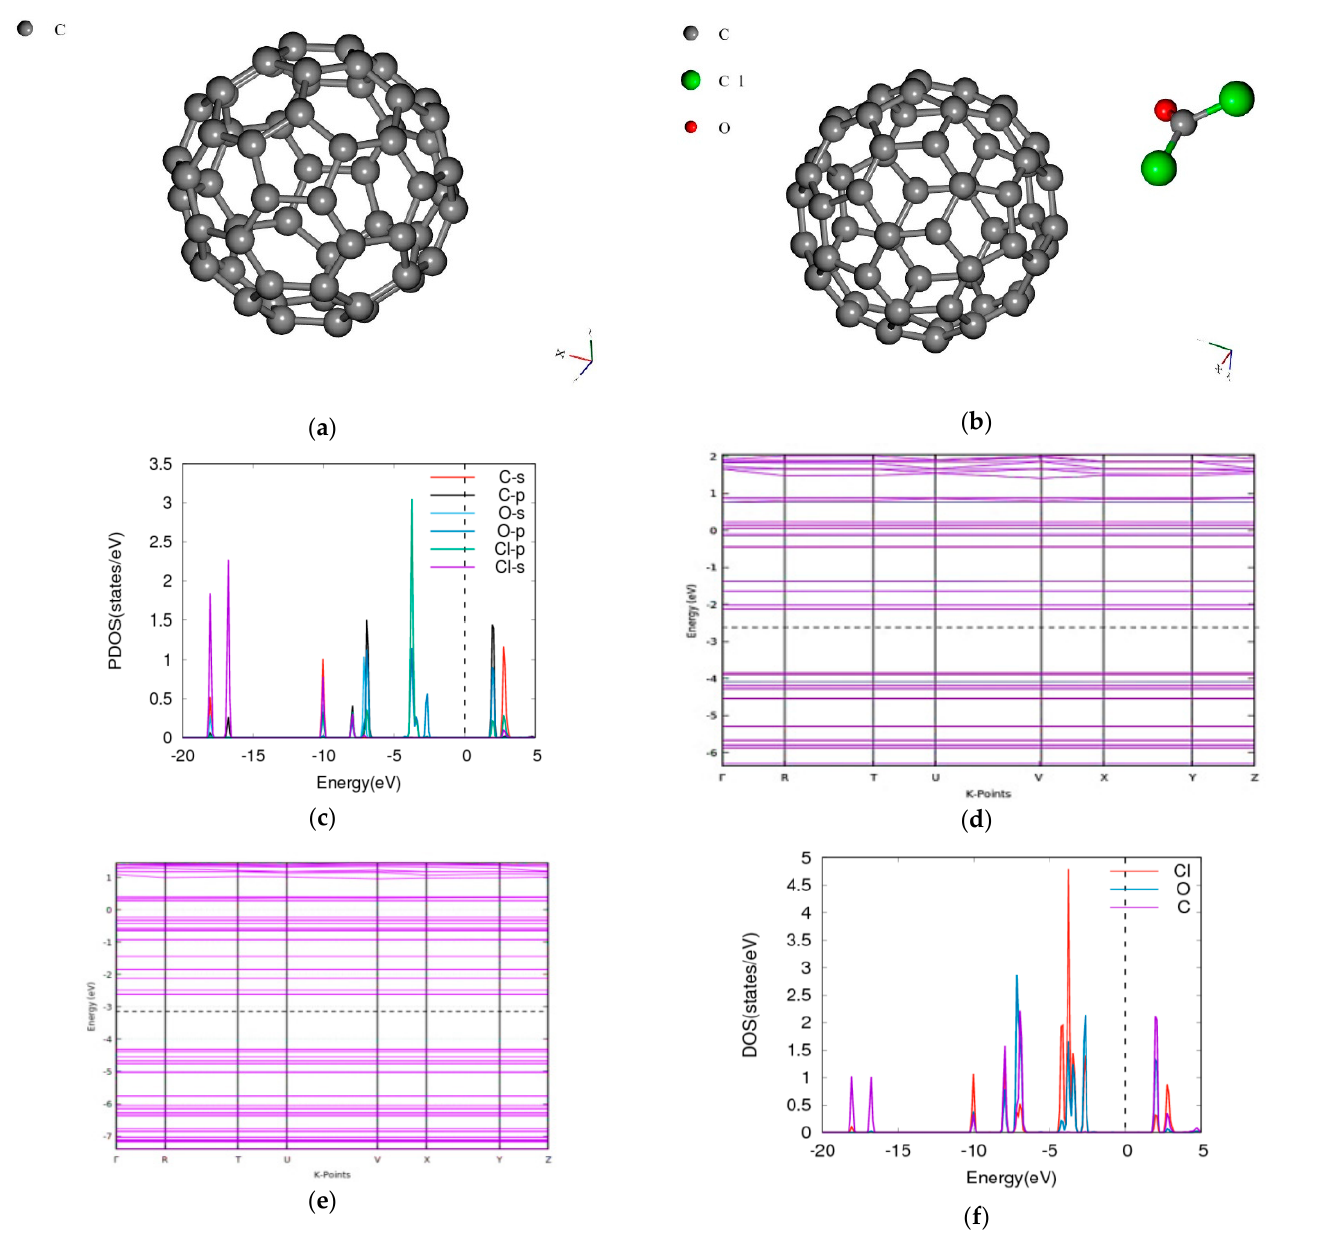
Figure 4. Band structure and density of states for phosgene gas interaction with C60. ( a ) C60, ( b ) phosgene- C60, ( c ) phosgene-C60 PDOS band-gap is ( d ) C60 band structure Eg = 1.6358 eV, ( e ) phosgene-C60 Eg = 1.6069 eV, ( f ) phosgene-C60 DOS.